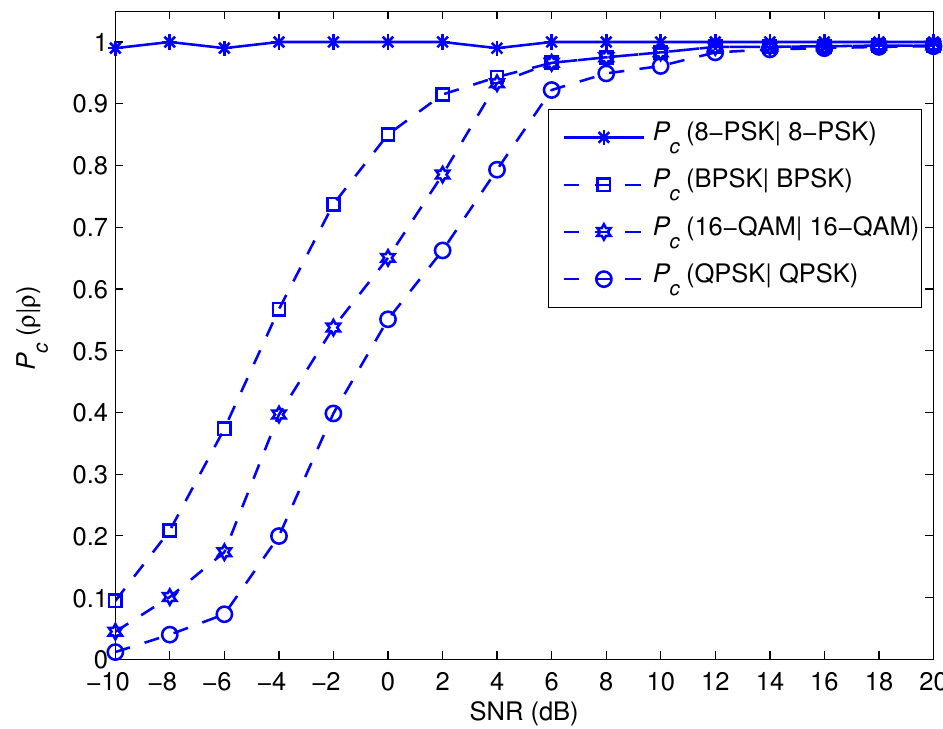
Figure 11. The categorization performance for the modulation set of Ω 4